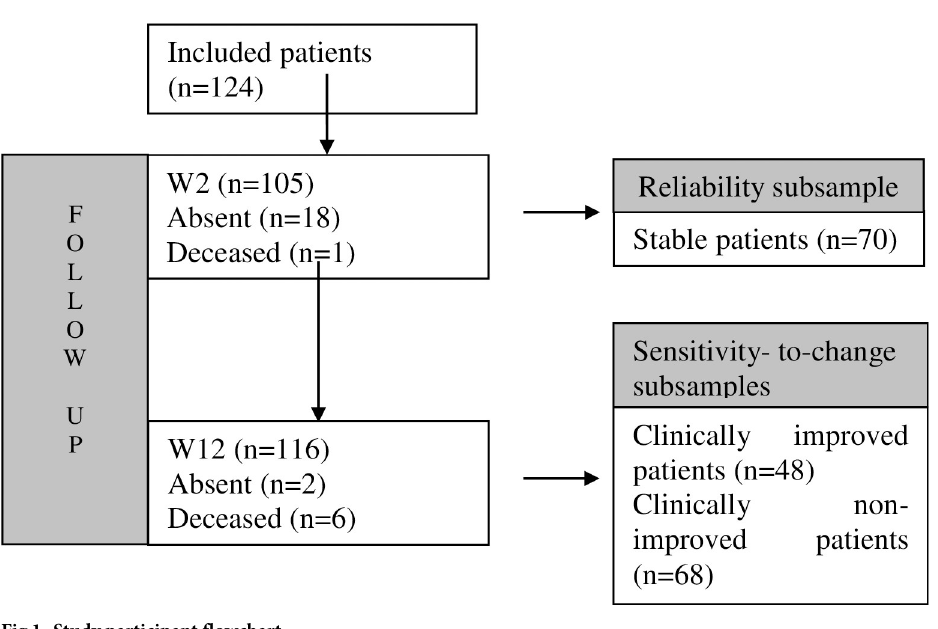
Fig 1. Study participant